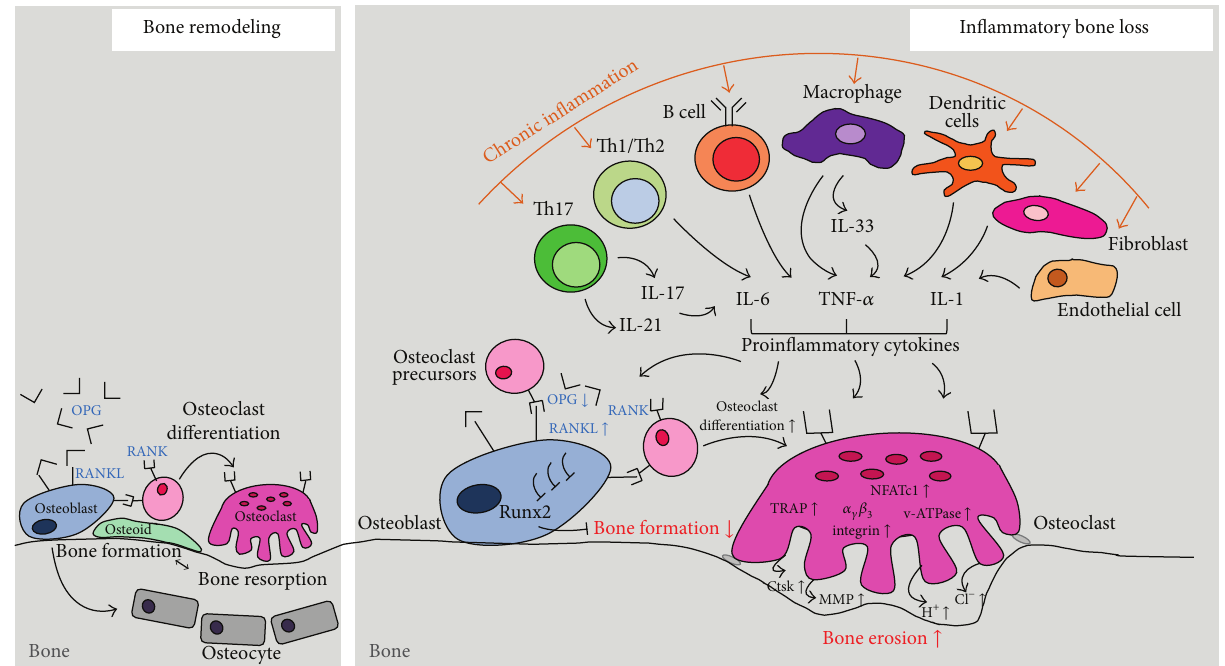
Figure 1: The role of inflammatory cytokine network in inflammatory bone loss. Bone remodeling is tightly regulated by the balanced action between bone-forming osteoblasts and bone-resorbing osteoclasts. In chronic inflammatory condition, inflammatory cytokine networks induce an uncoupling of bone formation and resorption that result in significant inflammatory bone loss. RANK: receptor activator of nuclear factor 𝜅 B. RANKL: RANK ligand. OPG: osteoprotegerin. Runx2: runt-related transcription factor 2. TRAP: tartrate-resistant acid phosphatase. NFATc1: nuclear factor of activated T cells cytoplasmic 1. v-ATPase: vacuolar-type H + -ATPase. MMP: matrix metalloproteinase. Ctsk: cathepsin